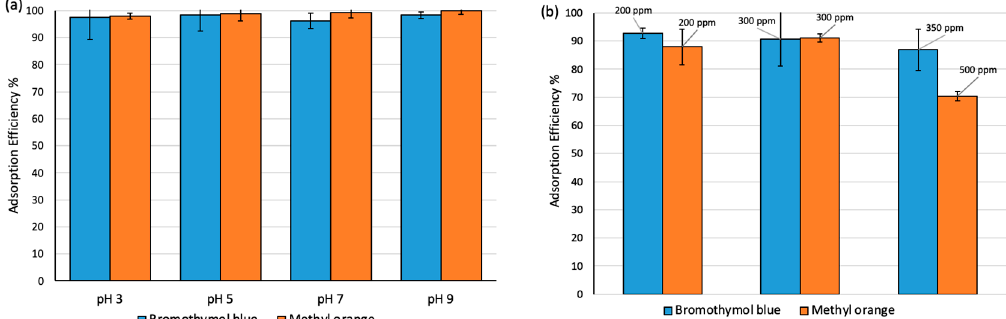
Figure 4. ( a ) Effect of pH on the extraction efficiency of MO and BT by Fe 3 O 4 -MSNs-PMETAC (contact time 3 h at 25 °C and concentration is 100 ppm). ( b ) Adsorption Efficiency (%) at different concentrations 200, 300, 350 and 500 ppm by Fe 3 O 4 -MSNs-PMETAC (pH = 7 and 80 min at 25 °C).